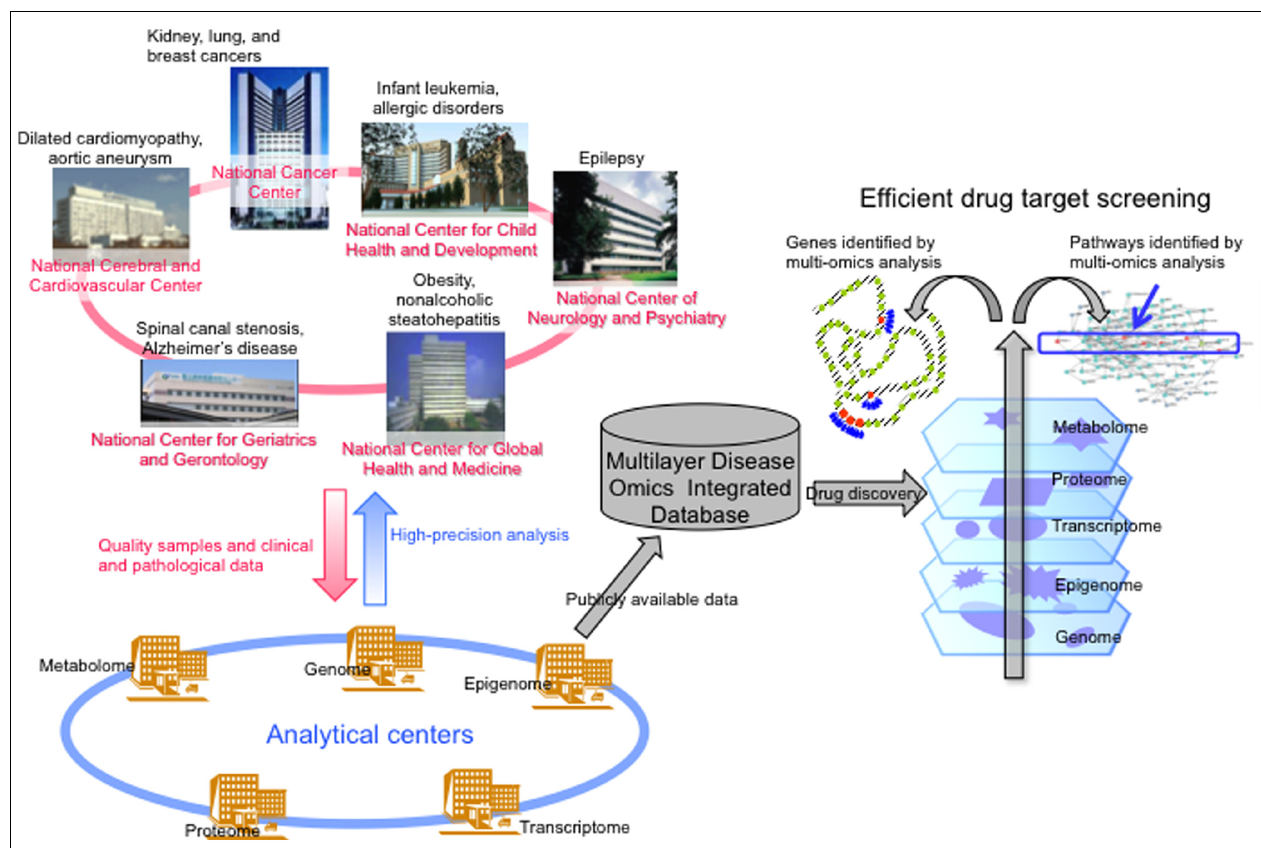
several National Centers in Japan have been split up into analytical centers for genome, epigenome, transcriptome, proteome, and metabolome.We have been focusing on molecules or molecular pathways that are impaired by multiple mechanisms, such as genome and epigenome events, or events in all five omics layers, which may participate in the molecular pathogeneses of those diseases and might become drug